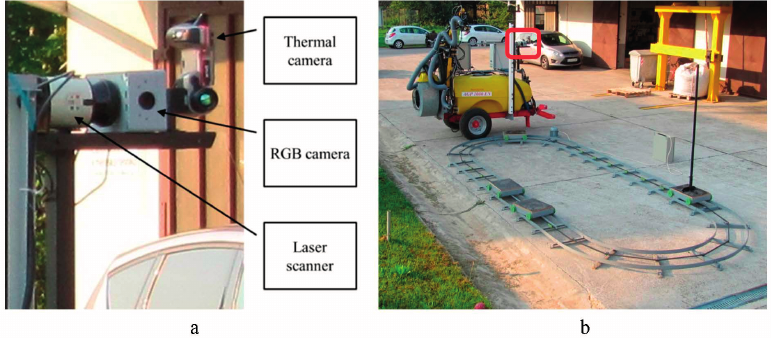
Figure 3. Selective sprayer. ( a ) sensors array; ( b ) overall sprayer with rail (red square, sprayer